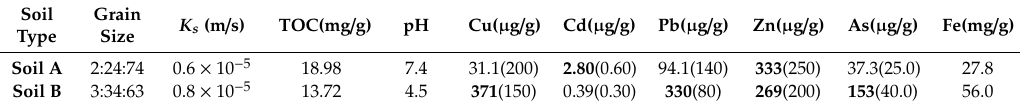
Table 1. Physical and chemical properties of experimental